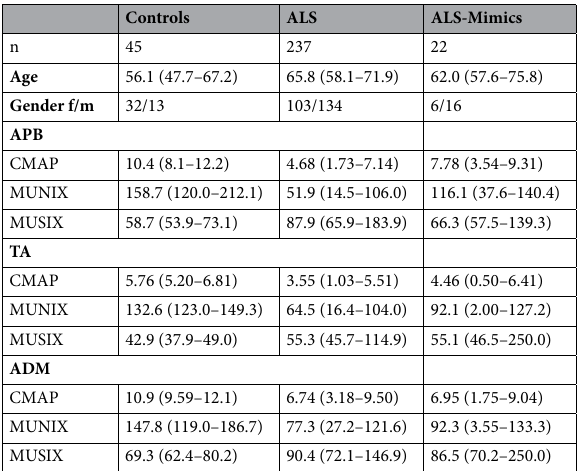
Table 1. Demographics and MUNIX parameters of the three cohorts. Parameters are given as median and interquartile range. CMAP is given in mV. f female, m